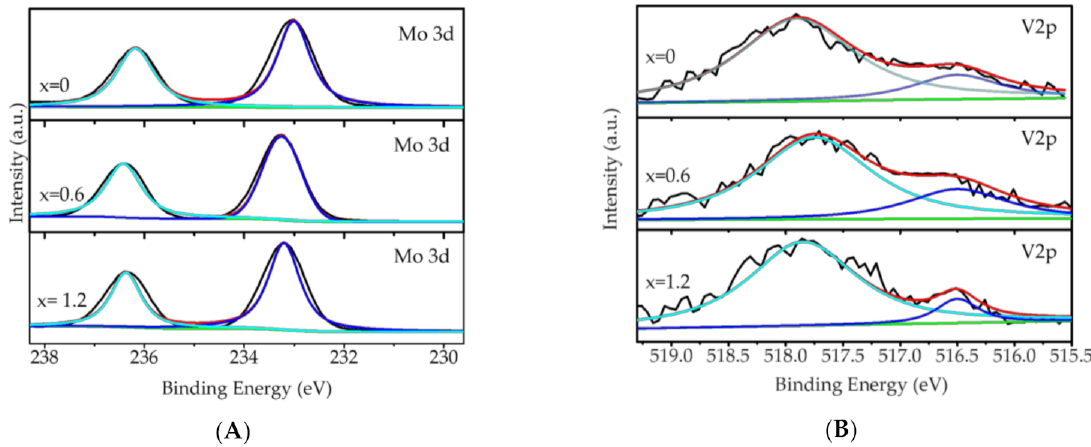
Figure 7. ( A ) Mo 3d and ( B ) V 2p 3/2 spectra of calcined